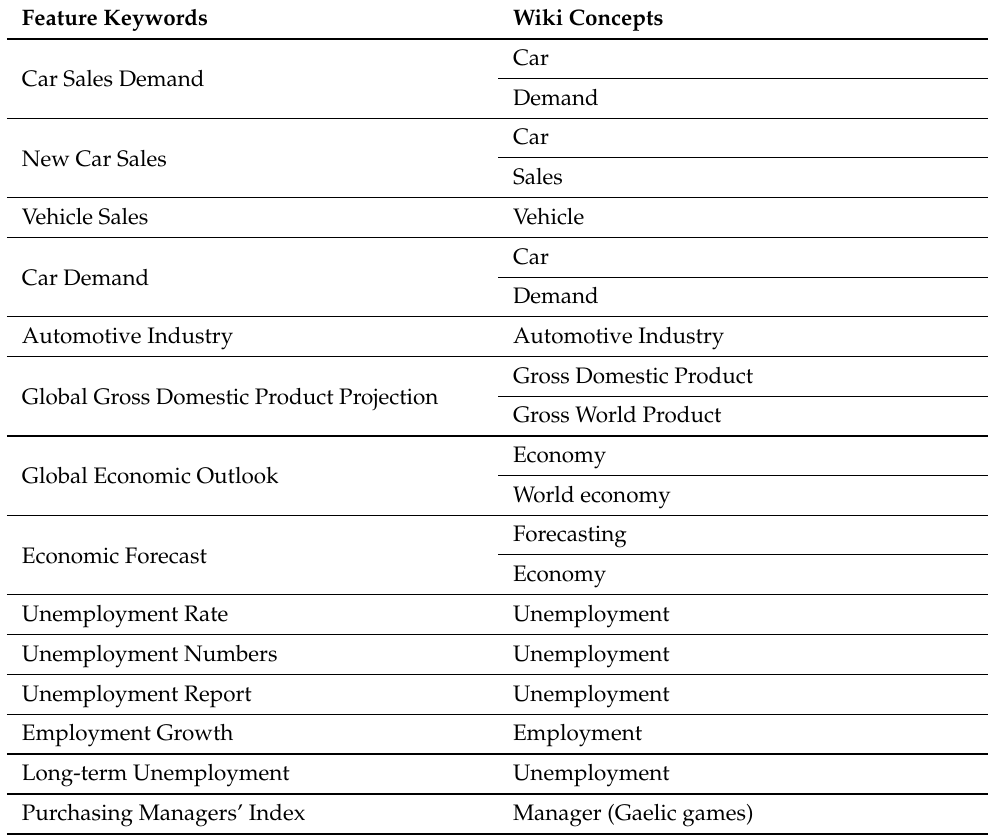
Table 1. Mapping between feature keywords and wiki concepts. Wikification was performed invoking the service available at https://wikifier.org (accessed on 27 April 2022). Note that while most concepts were accurate, the wikification of the Purchasing Managers’ Index produced a wrong